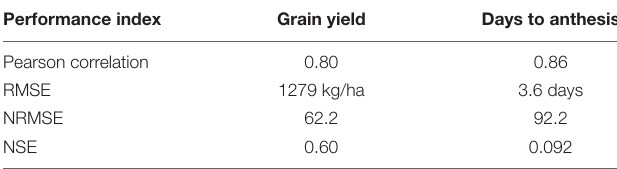
TABLE 3 | Measures of agreement between model and measured